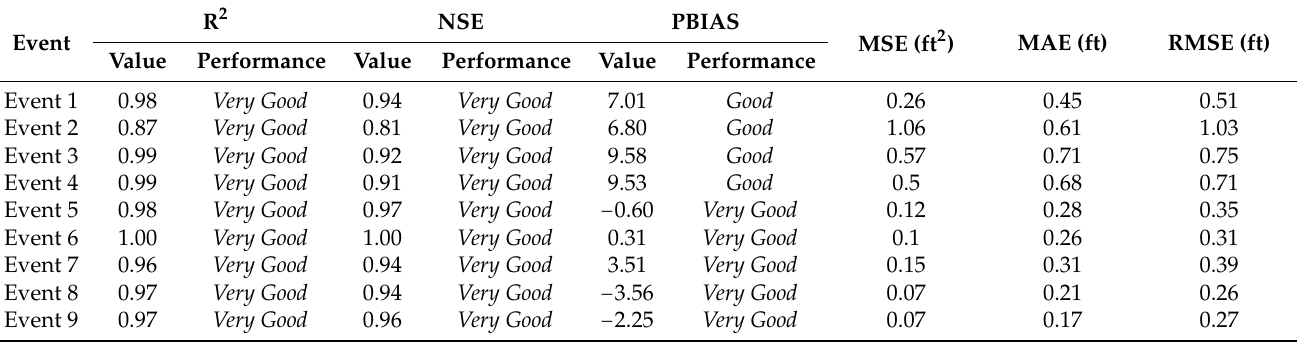
Table 3. Event-based comparison and